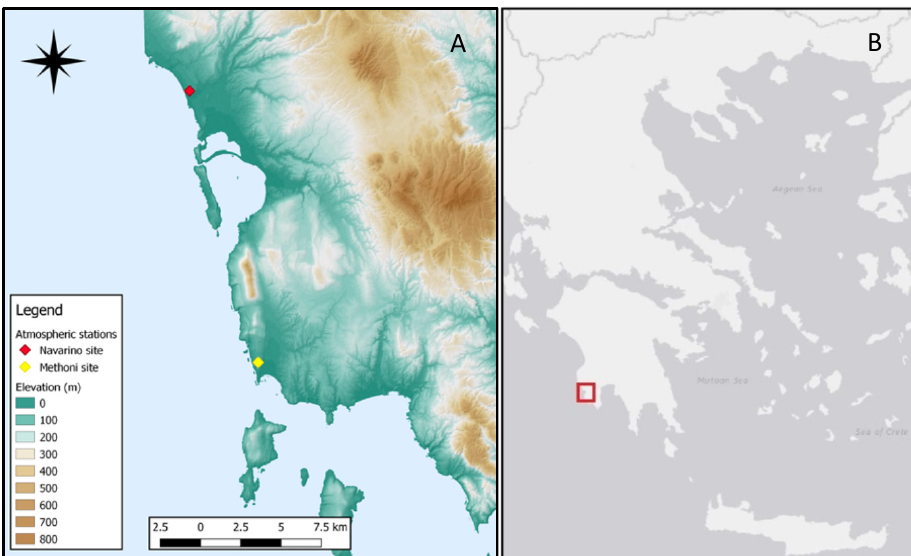
Figure 1. Map A showing Messina, the southwest region of Peloponnese (mark with a red square in Map B ), in the south west of Greece. NEO is situated at the coast about 11 km north the nearest city Pylos. The Methoni site is about 11 km south